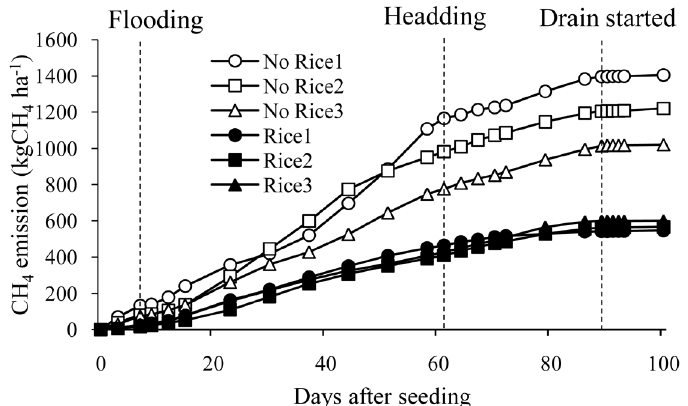
Figure 2. Cumulative CH emissions in paddy fields. Cumulated CH 4 cropping rice fields in the Mekong Delta. The number in the legend relates to the fields.